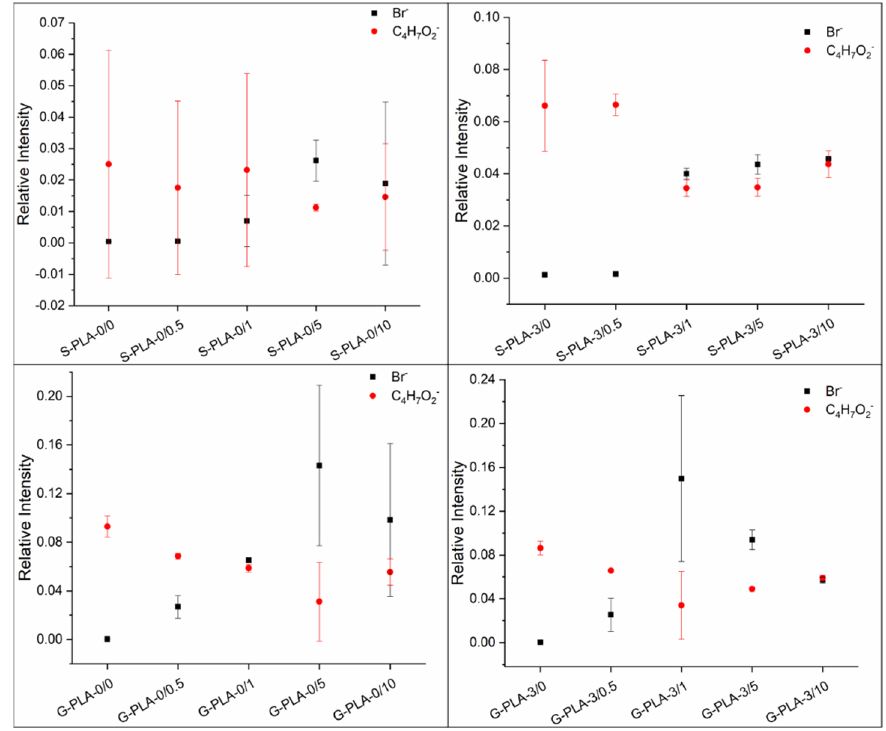
Figure 1. Relative intensities of Br − and C 4 H 7 O 2 − ions as a function of sample type for PLA films containing CTAB and Mg casted on silicone and glass.